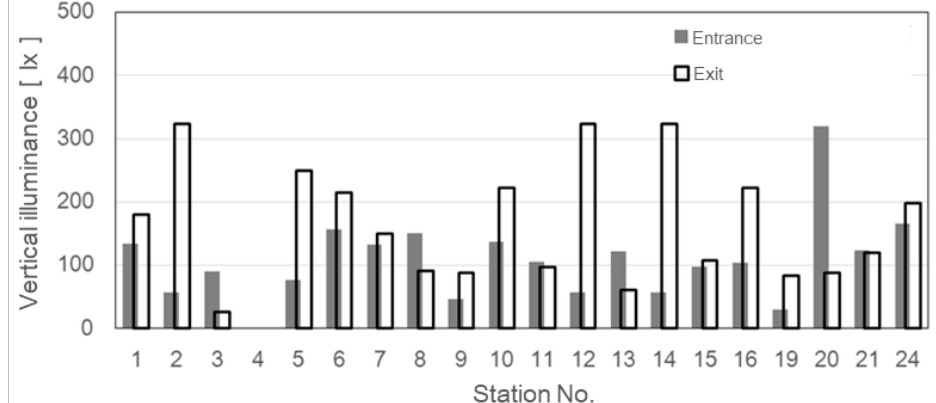
Figure 10. Comparison of vertical illuminance measurement results at the entrance and exit of stairs.